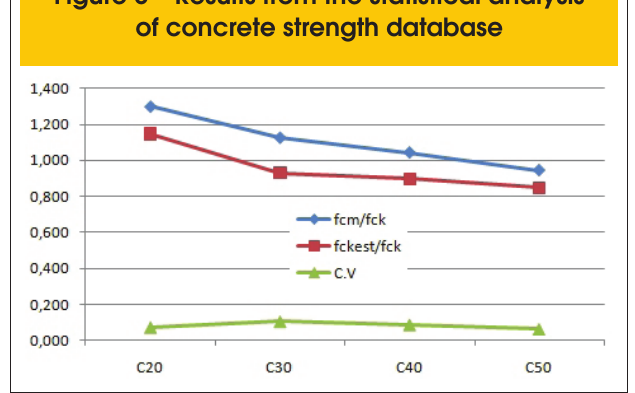
Figure 3 – Results from the statistical analysis of concrete strength